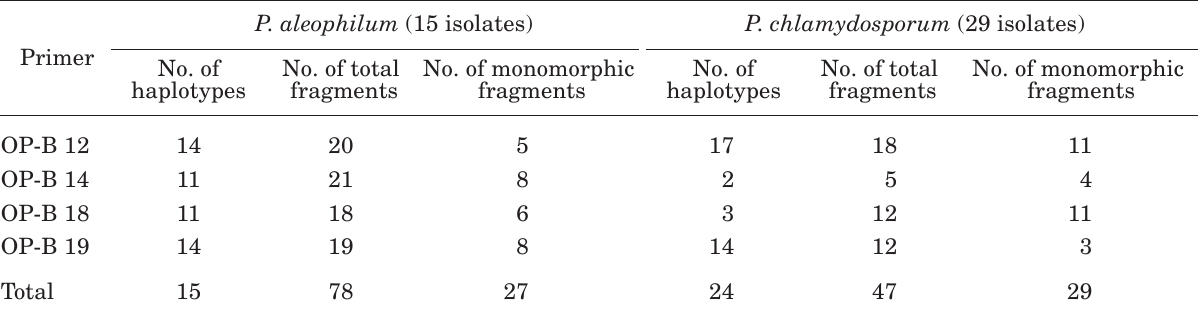
Table 3. Number of haplotypes, and of total and monomorphic fragments obtained with each RAPD primer from Phaeoacremonium aleophilum and P. chlamydosporum